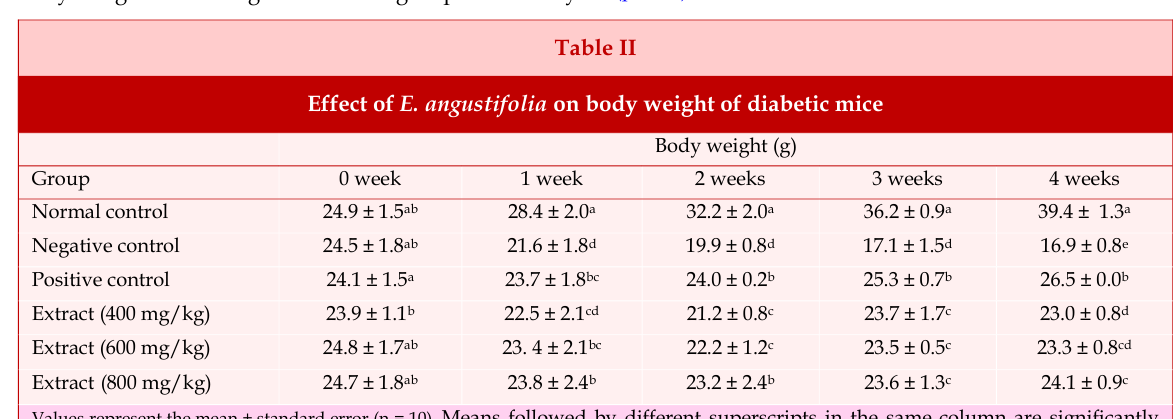
Figure 1: Effect of E. angustifolia on total cholesterol, triglycer- ide and HDL-C levels in diabetes mice. Different lowercase letters indicate significant differences between means